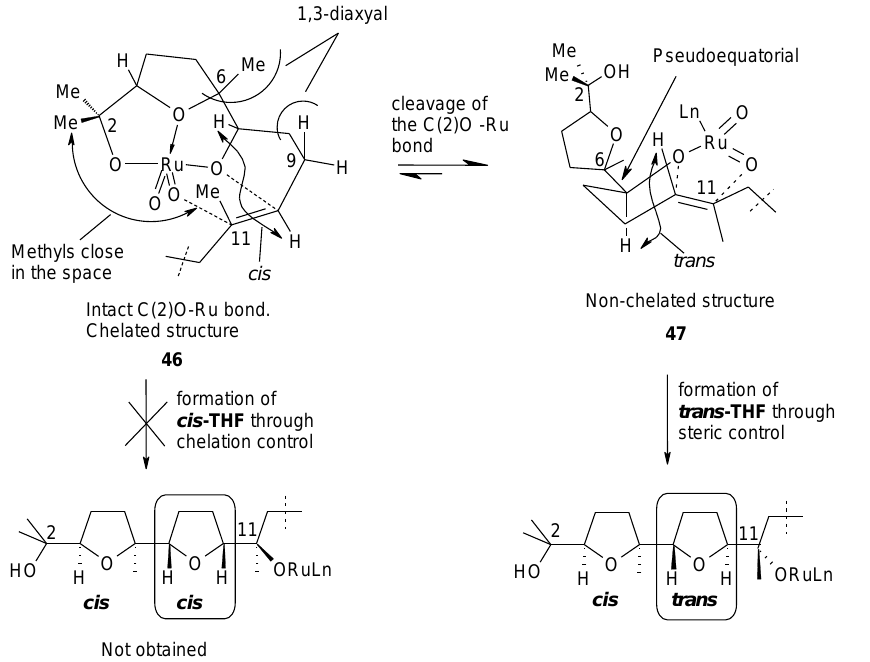
Figure 4. Chelation versus steric control in the second cyclization step of digeranyl